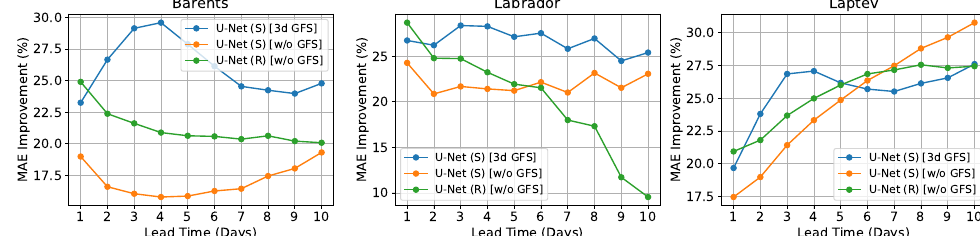
Figure 13. Dependence of JAXA SIC MAE relative improvement over persistence (higher is better) on the different forecast horizons (in days) for all three regions. MAE is averaged over the whole year 2021. U-Net (S) and U-Net (R) are trained on all three regions merged and shuffled with 7 days history (past) and best inputs configuration, as presented in Table